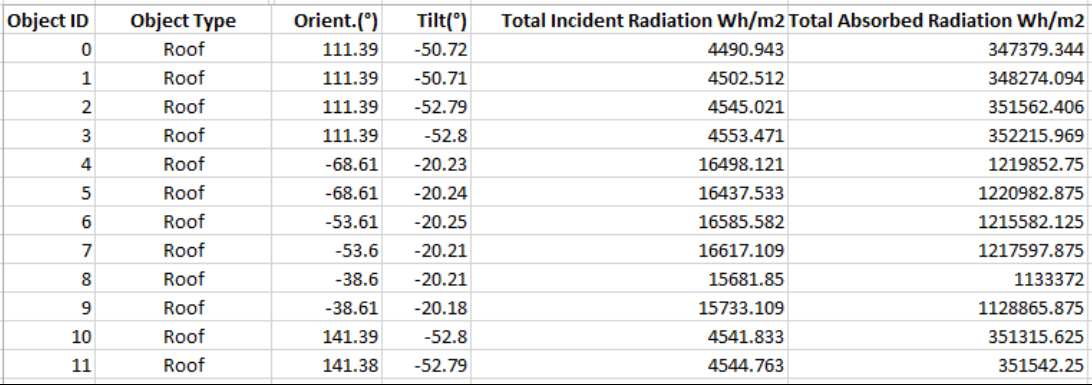
Figure 5. Retrieved records from the database .